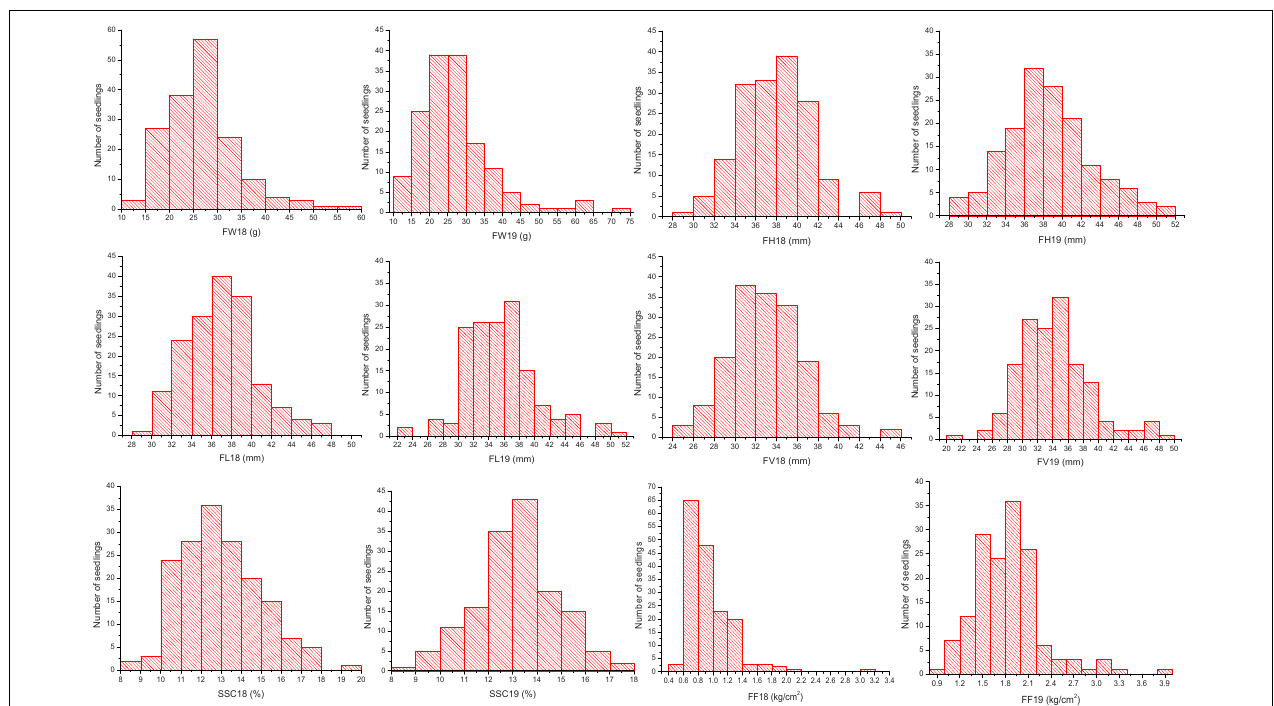
FIGURE 1 | Frequency distribution of phenotyping data for each trait in 2018 and 2019.